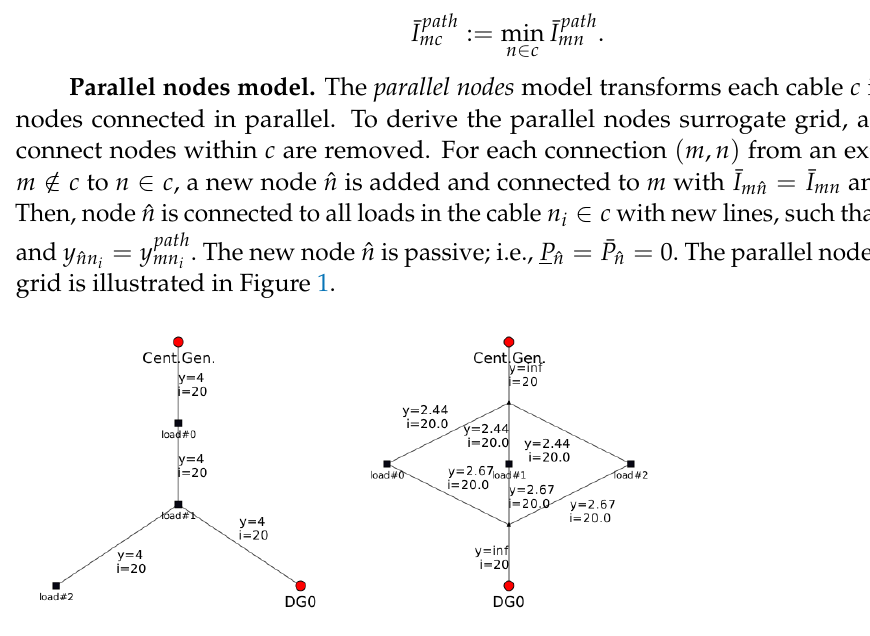
Figure 1. An example of the parallel nodes surrogate grid. Rectangular nodes are loads, and red circle nodes are generators. Line capacity is denoted by y and current limit by i